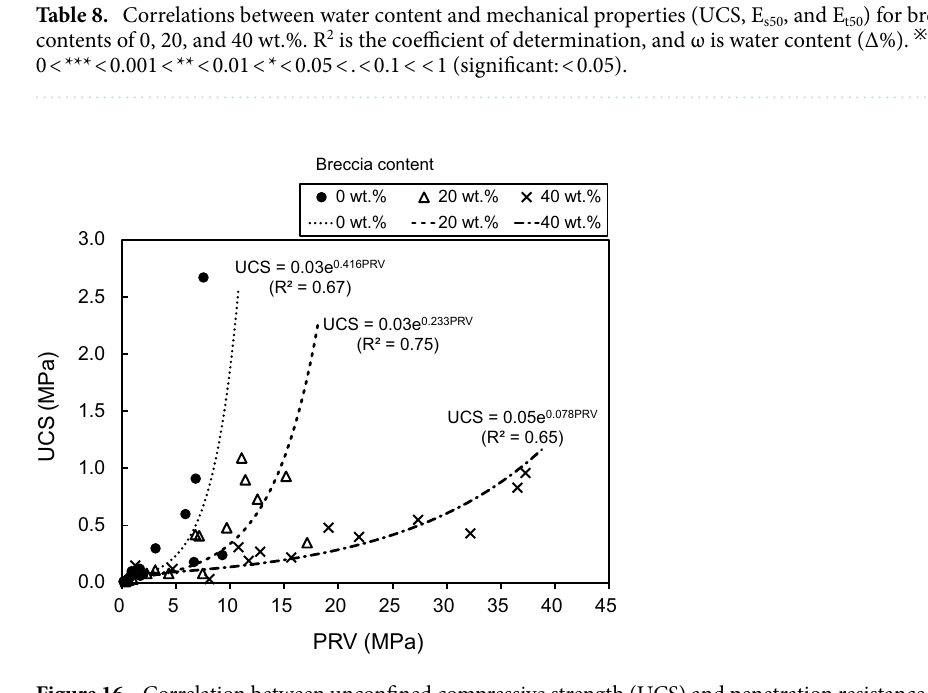
Figure 16. Correlation between unconfined compressive strength (UCS) and penetration resistance value (PRV) with respect to three levels of breccia content (0, 20, and 40